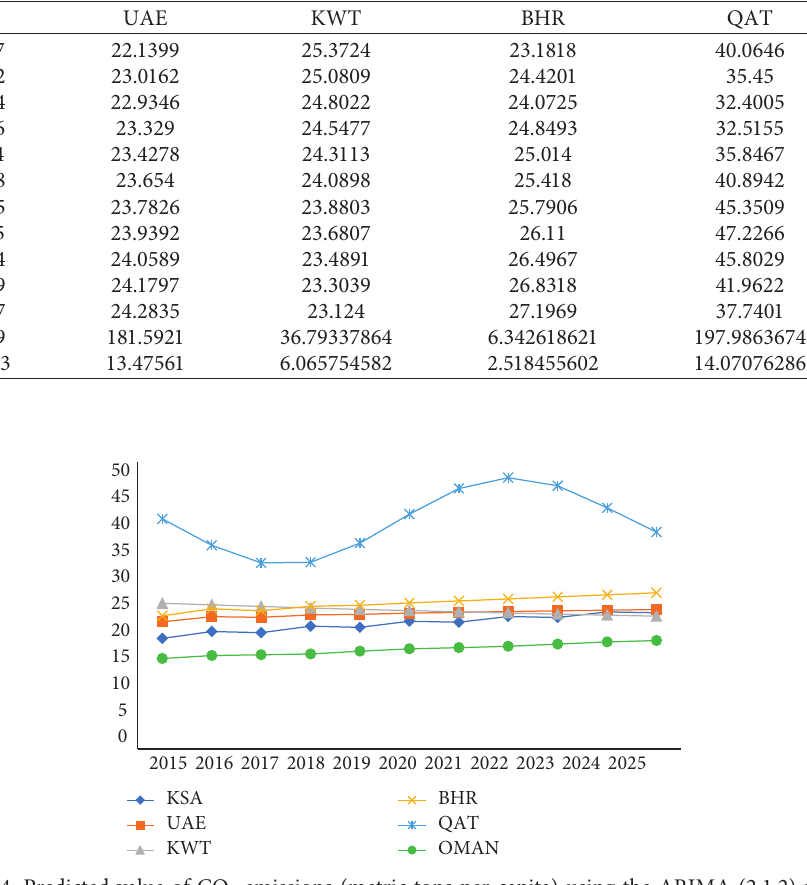
Figure 3: Predicted value of CO 2 emissions (metric tons per capita) using the ARIMA (1,1,2) model. Table 3: Predicted value of CO 2 emissions (metric tons per capita) using the ARIMA (2,1,2) model and accuracy measures.